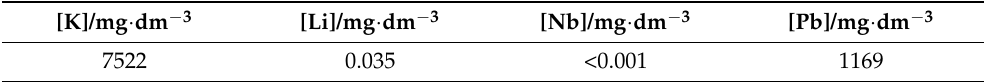
Table 2. Elemental composition of the reaction salt medium (molten KNO 3 -PbCl 2 mixture) after the experiment.